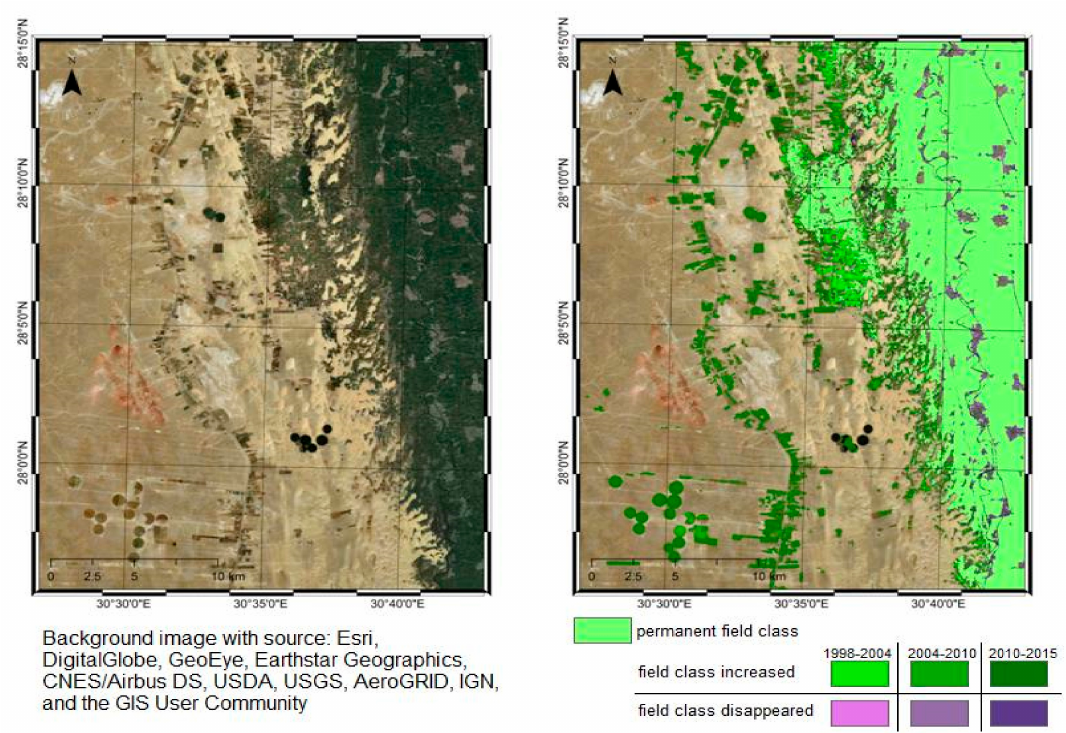
Figure 12. Field classes detected for 1998, 2004, 2010 and 2015 in the Eastern South-Rayan dune field area overlaid on high-resolution optical image (right) and optical image over the area (left).